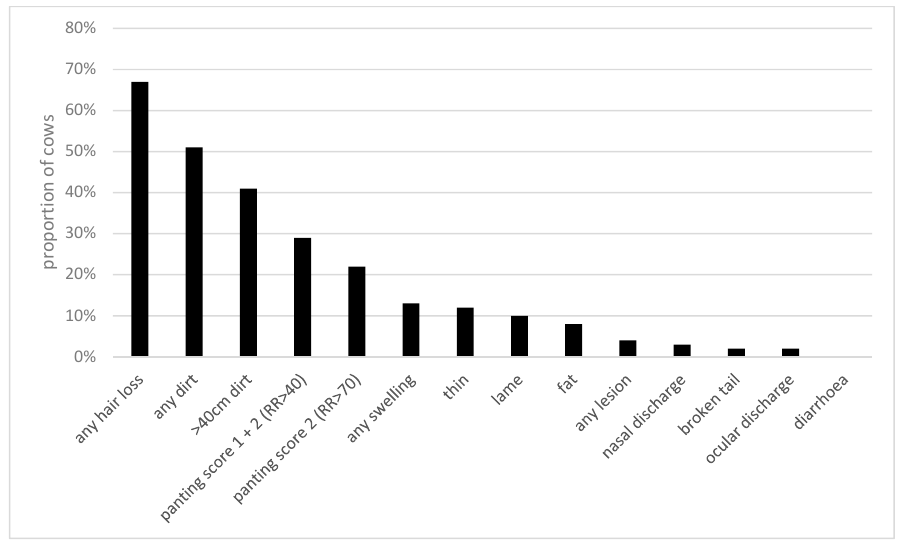
Figure 3. The proportion of cows recorded with each measure (n = 169–391).